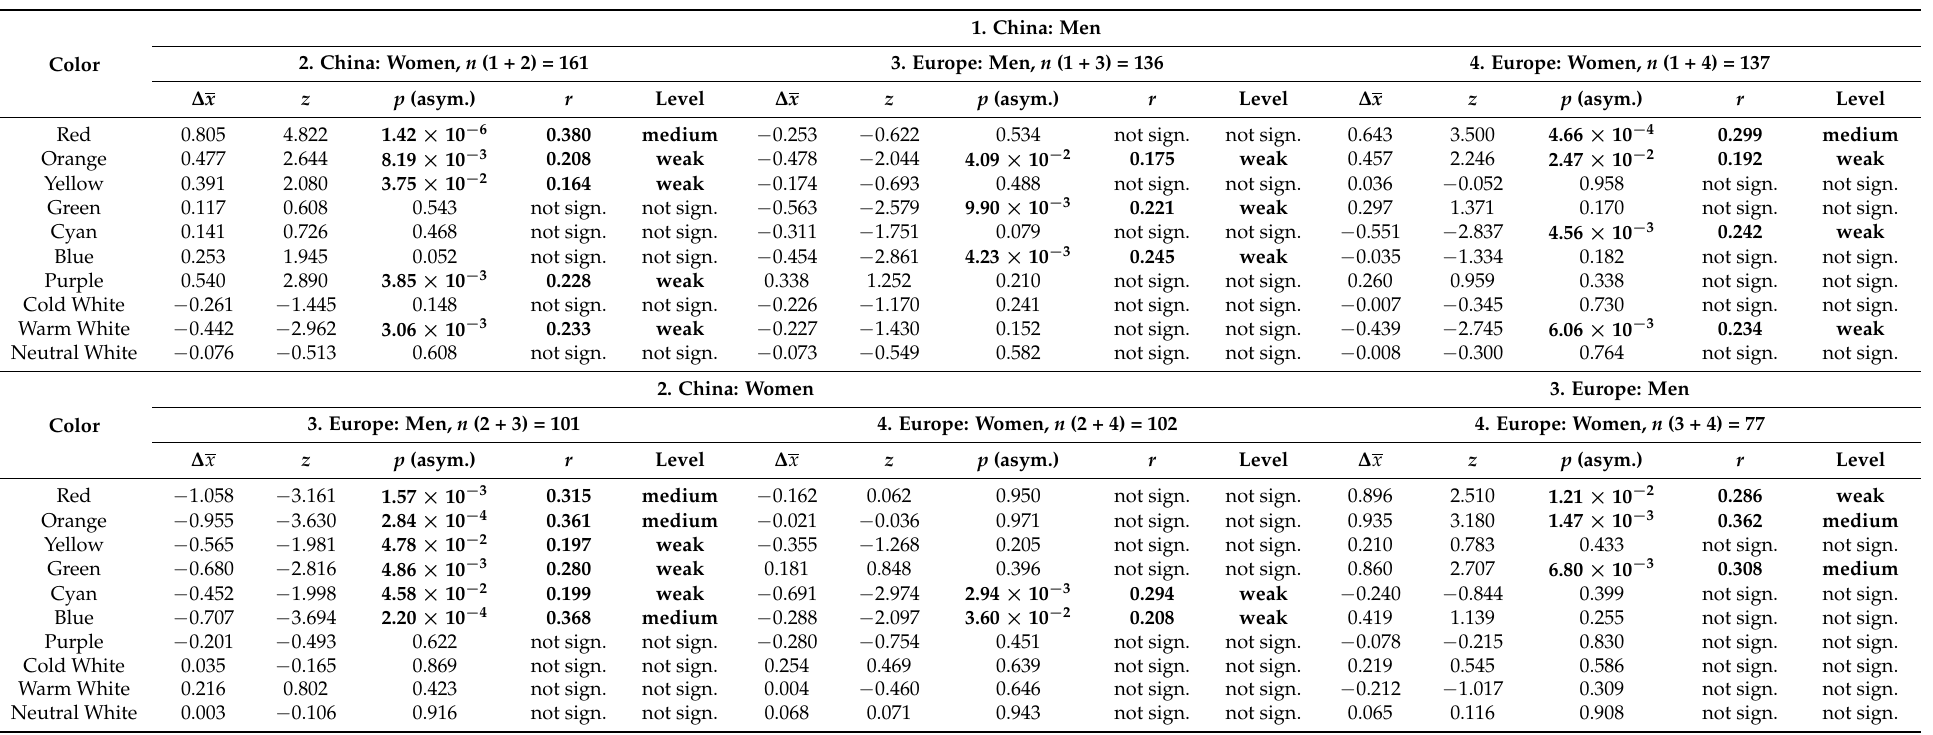
Table 7. Statistical evaluation of the color preference rating, differences of the mean values ∆ x , z-score, probability value p , effect power r and quantification of it. If p < 0.05, it is bold marked. Participants for each group are summed up in the